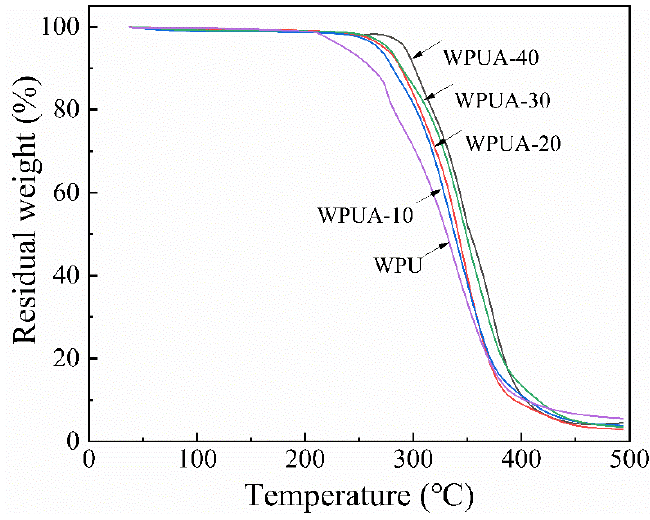
Figure 2. Thermogravimetric curves of WPU, WPUA-10, WPUA-20, WPUA-30, and WPUA-40 coatings.